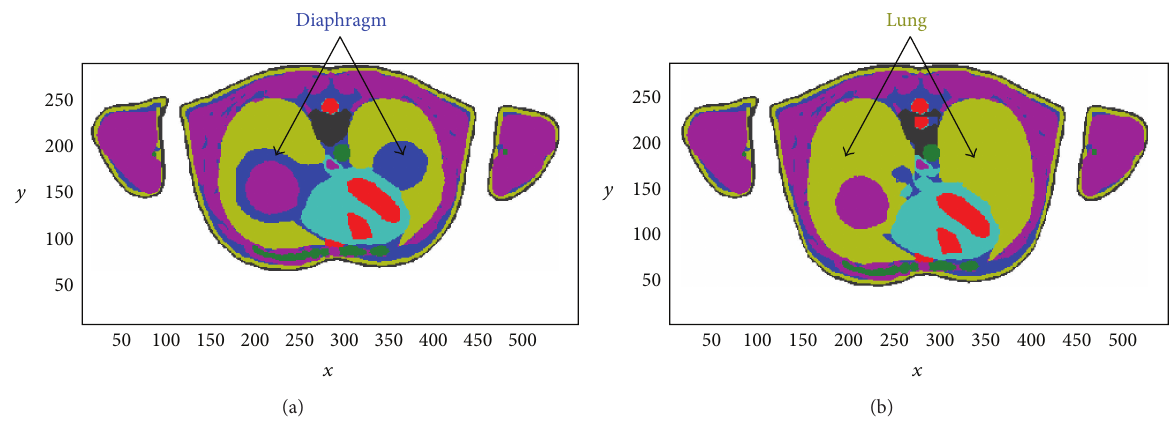
Figure 2: Bidimensional representation of an axial section ( 𝑧 = 130 cm) for the RS (a) and DB (b) model.